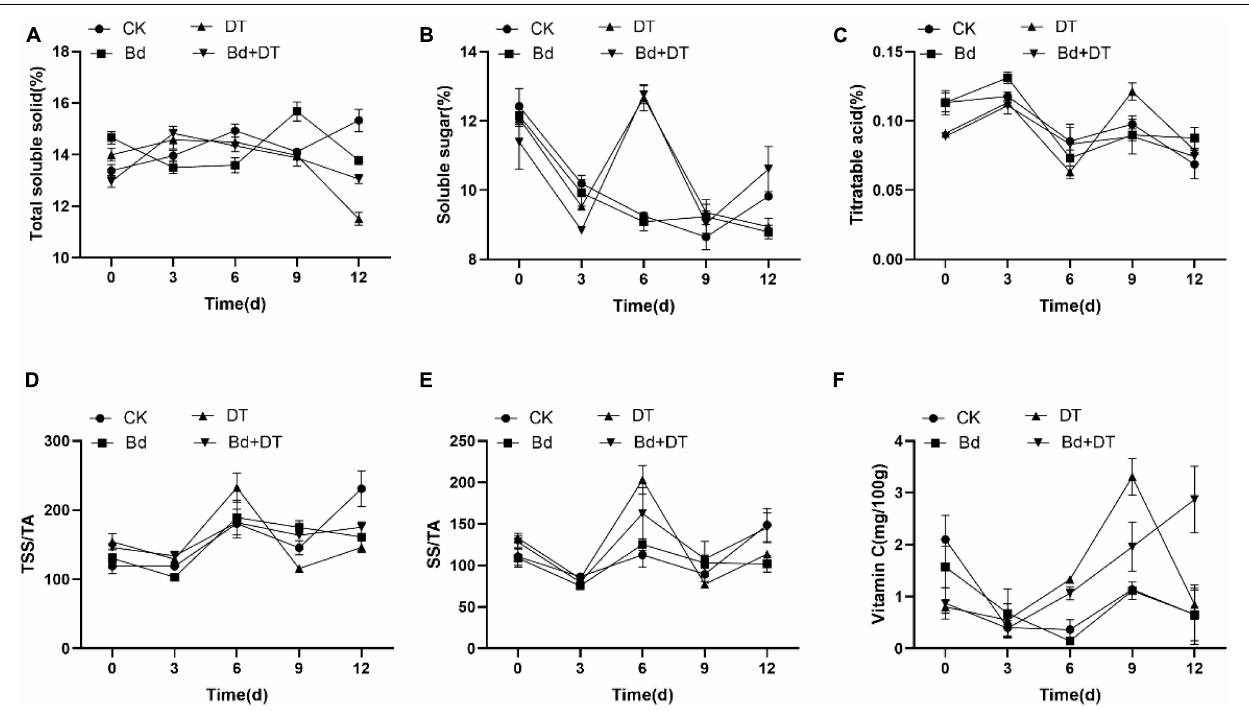
FIGURE 7 | The dynamic changes of internal quality indexes including total soluble solid (A) , soluble sugar (B) , titratable acidity (C) , TSS/TA (D) , SS/TA (E) , and vitamin C (F) in the different treatment fruit.